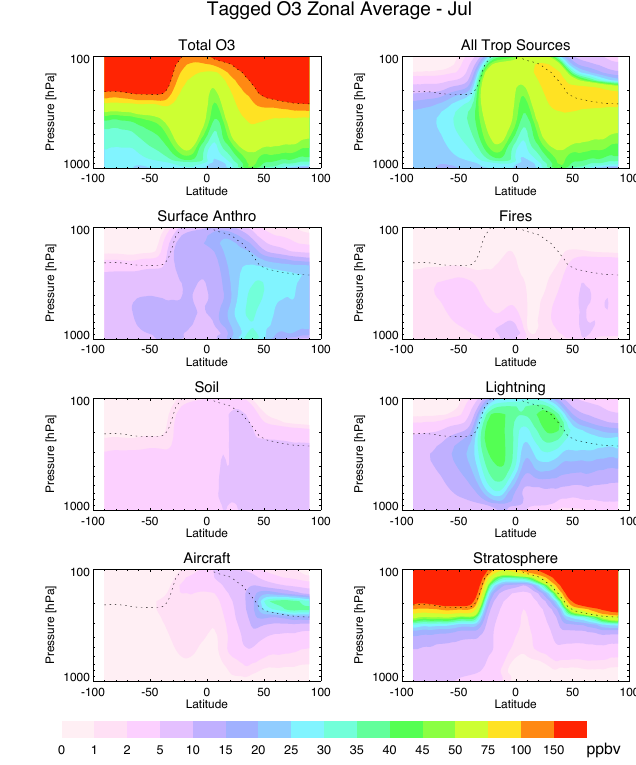
Fig. 5. As previous figure, for July 2008. soil, lightning and aircraft emissions), we can determine the amount of ozone produced from tropospheric sources and, thus, the stratospheric contribution from the difference of the tagged amount and the total ozone. Figure 8 shows the stratospheric contribution determined from the tagged tropospheric sources, as well as from the tra- ditional “O3S” tracer. The O3S tracer gives a much greater estimate of stratospheric ozone than the tagged ozone does, both in the mid-troposphere and at the surface. At the surface, where O3S shows over 20 ppbv, the tagged ozone gives no more than 8 ppbv. Hess and Lamarque (2007) showed simi- lar differences in zonal averages of surface O3S and tagged ozone. The vertical distributions of tagged ozone shown in Figs. 4 and 5 illustrate that a significant amount of tropo- spheric air gets into the stratosphere (i.e., above the 150 ppbv ozone contour). With the O3S tracer, those contributions would get reset to stratospheric air, but the tagging method preserves those as tropospheric sources. When considering the whole troposphere (ozone less than 150 ppbv), the frac- tion of the tropospheric ozone burden that is from the strato- sphere is 58 % based on O3S, and 17 % based on the tagged ozone. These differences are comparable to those found us- ing different measures by Emmons et al. (2003) in an analysis of the Northern Hemisphere springtime ozone